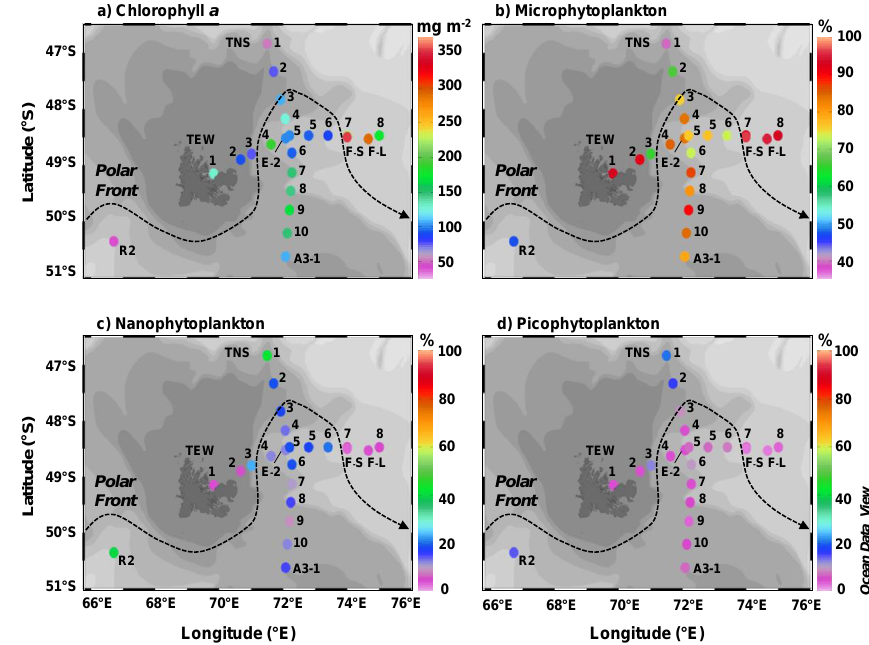
Figure 2. Figure 2. Distribution of depth-integrated total chlorophyll a (a) and contribution of micro- (b) , nano- (c) , picophytoplankton (d) commu- nities to total biomass. Vertical integrations were made from the surface to 200m except for the coastal stations TEW-1 and TEW-2 where data were integrated down to 70m. The TNS transect (comprising station A3-1) was sampled from 20 to 23 October, while the TEW tran- sect (comprising station E-2) was sampled between 31 October and 2 November. Station R2 was sampled between the two transects on 25 October, while stations F were sampled after the two transects, on 6 November (F-L), and 8 November (F-S). The dashed line represents the polar front